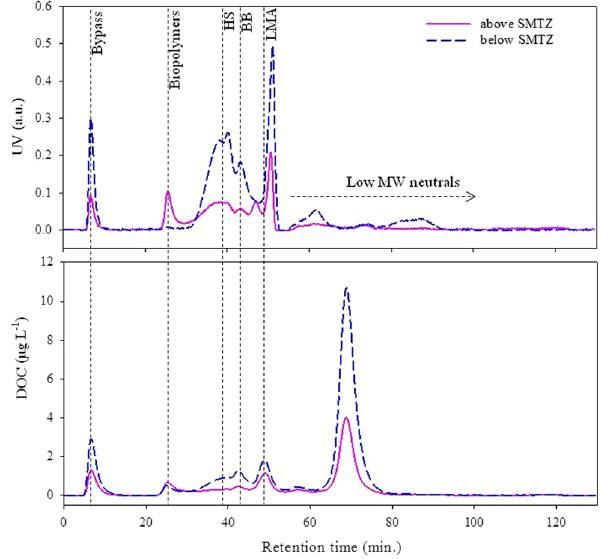
Figure 6. SEC-UVD (254 nm) and SEC-OCD of PWDOM above and below the SMTZ. Biopolymers ≥ 10 kDa. HS = humic substances; BB = building blocks; LMA = low molecular weight acids. Bypass was to obtain a detector signal at the dead volume time of each